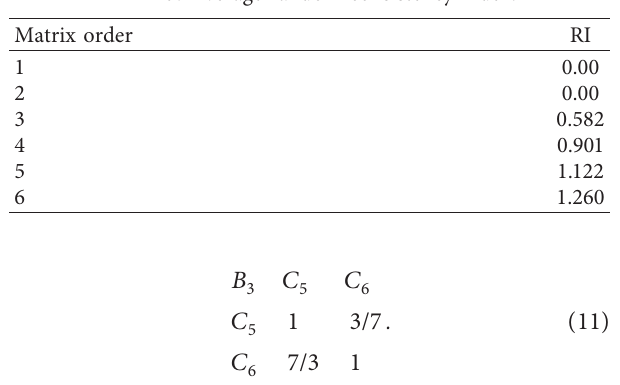
Table 5: Average random consistency index. Table 6: Weight of the BVCE index.